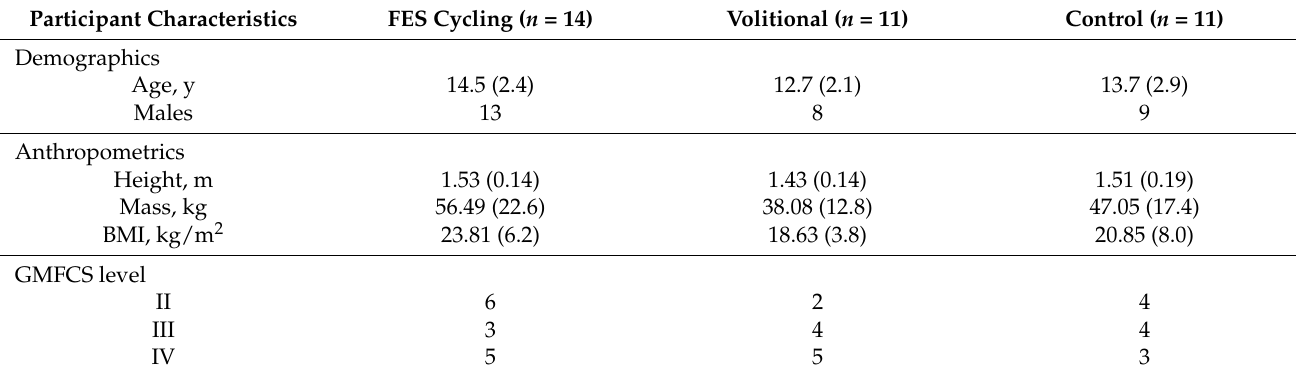
Figure 1. Participant flow diagram illustrating the number of participants who were randomly assigned, received the intended treatment, and analyzed for the cardiovascular outcomes for each group. Table 2. Baseline characteristics of participants. Average age, height, mass, and BMI differences (mean ± SD) between the three groups: FES cycling group, volitional group, and the control group. Participant